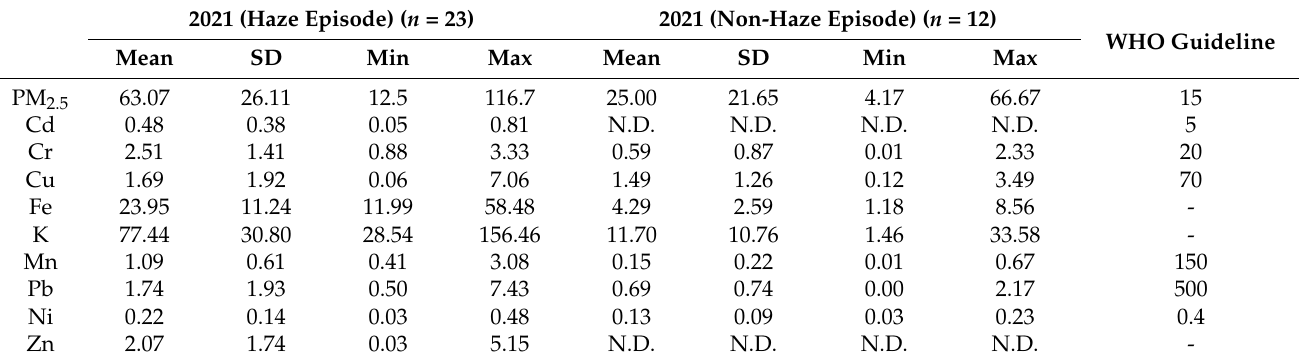
Table 1. Average concentration of PM 2.5 ( µ g/m 3 ) and elemental component (ng/m 3 ). 2021 (Haze Episode) ( n = 23) 2021 (Non-Haze Episode) ( n = 12)